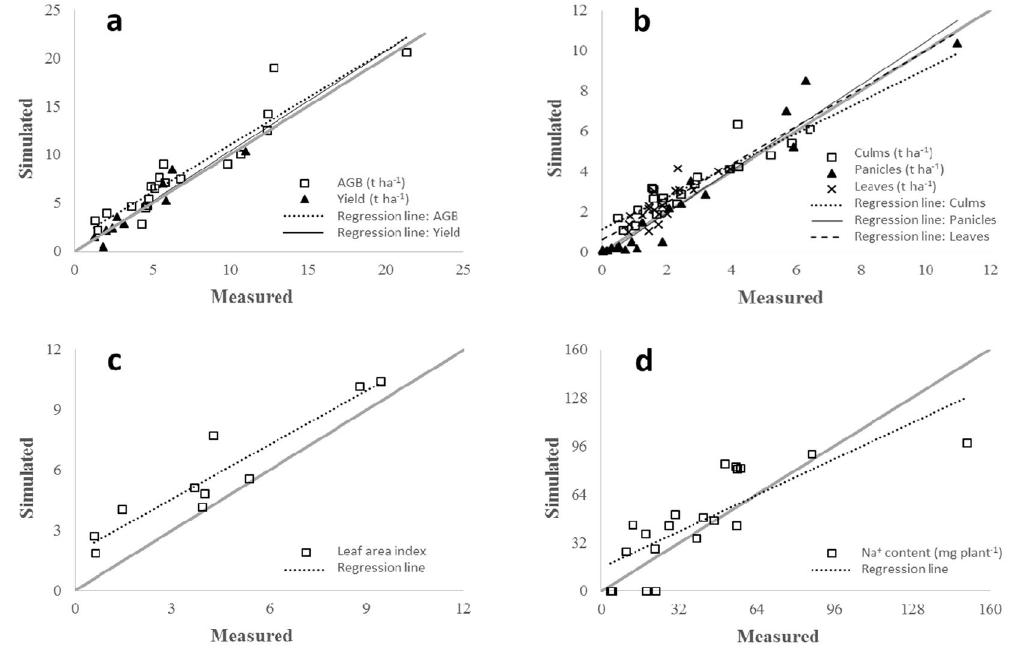
Figure 2. Measured and simulated values of ( a ) aboveground biomass (AGB) and yield, ( b ) biomass of culms, leaves and panicles, ( c ) leaf area index, and ( d ) plant sodium content. The grey line indicates the 1:1 agreement between measured and simulated